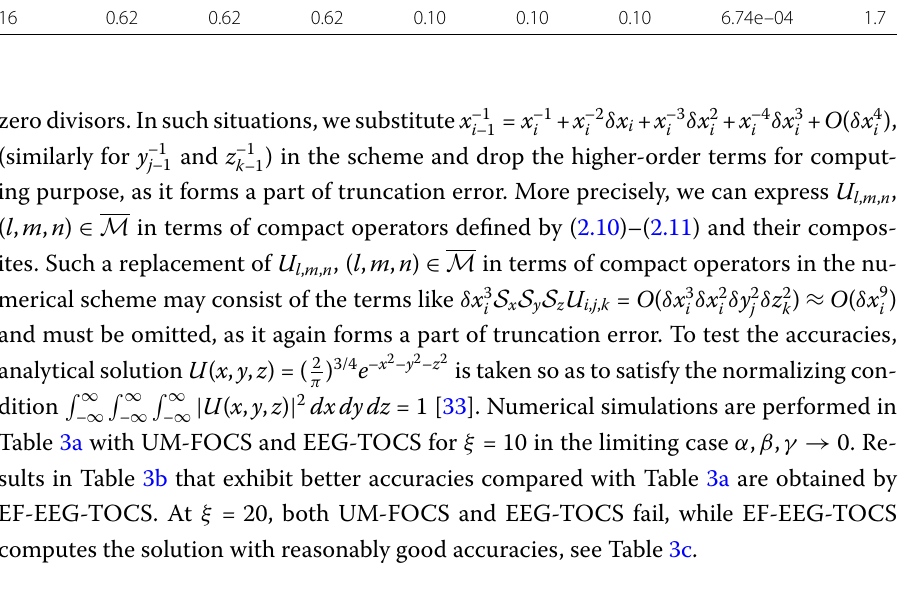
Table 3a with UM-FOCS and EEG-TOCS for ξ = 10 in the limiting case α , β , γ → 0. Re- sults in Table 3b that exhibit better accuracies compared with Table 3a are obtained by EF-EEG-TOCS. At ξ = 20, both UM-FOCS and EEG-TOCS fail, while EF-EEG-TOCS computes the solution with reasonably good accuracies, see Table